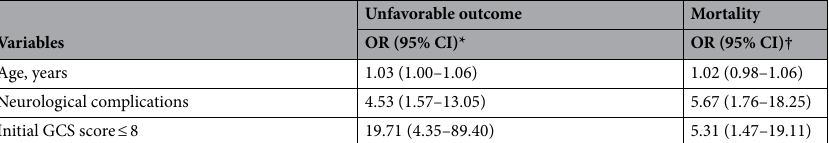
Table 5. Multivariate analysis for unfavorable outcome and mortality at 3 months. Patients with premorbid mRS scores 0–2 were analyzed (n = 124). *Sex, healthcare-related meningitis, concurrent infection, and high-sensitivity C-reactive protein > 10 mg/dL were included as covariates. †Sex, healthcare-related meningitis, immunocompromised status, thrombocytopenia < 100,000/mm 3 , and high-sensitivity C-reactive protein > 10 mg/dL were included as covariates. Abbreviations: OR, odds ratio; CI, confidence interval; GCS, Glasgow coma